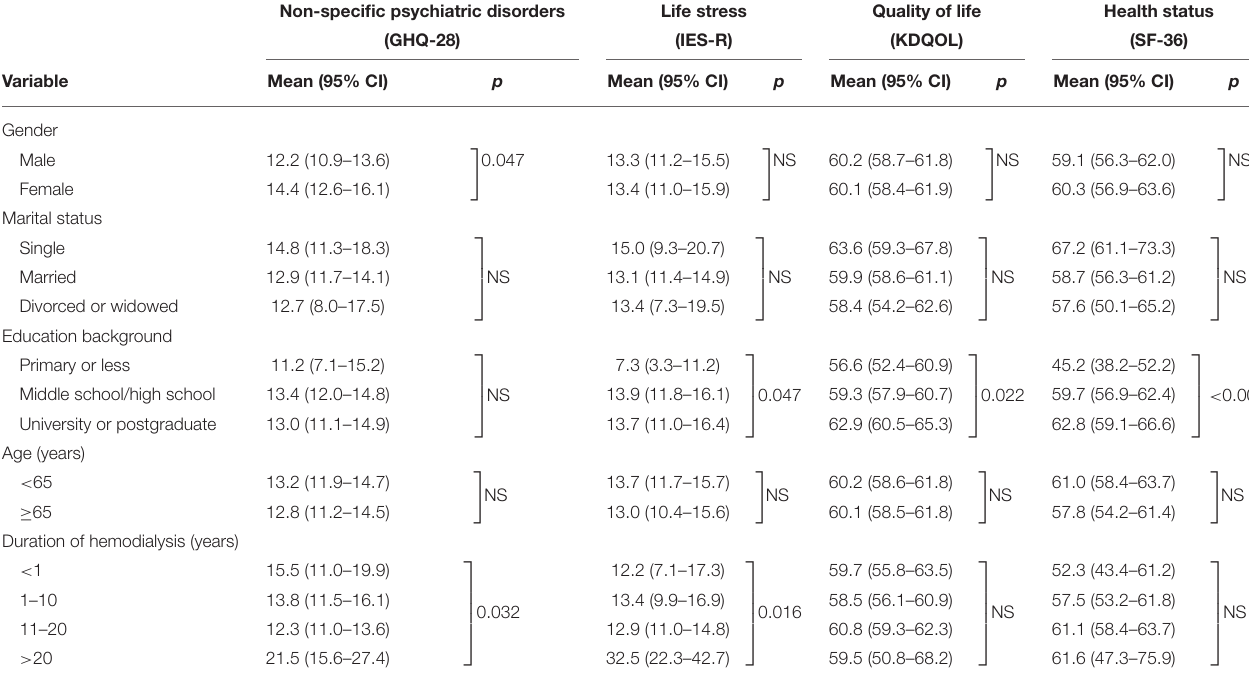
TABLE 4 | Effects of demographic and exposure variables on mental status and quality of life of the patients during ongoing COVID-19 pandemic.